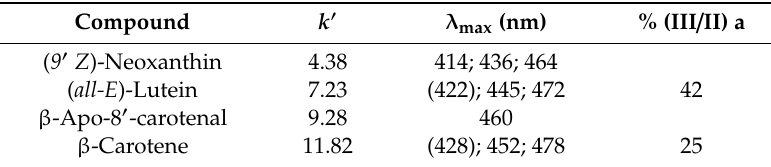
Table 1. High Performance-Liquid Chromatography (HPLC) / DAD characteristics of carotenoids found in Nebbiolo